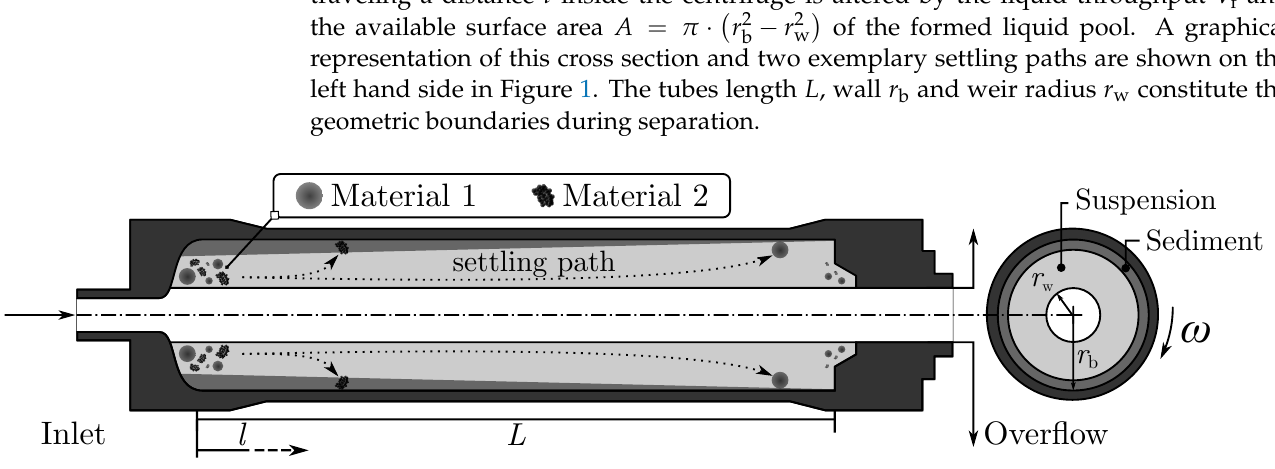
Figure 1. Schematic view of a tubular centrifuge rotor illustrating the separation zone with its length L , exemplary settling paths of two suspended materials ( left ) and an axial cross section ( right